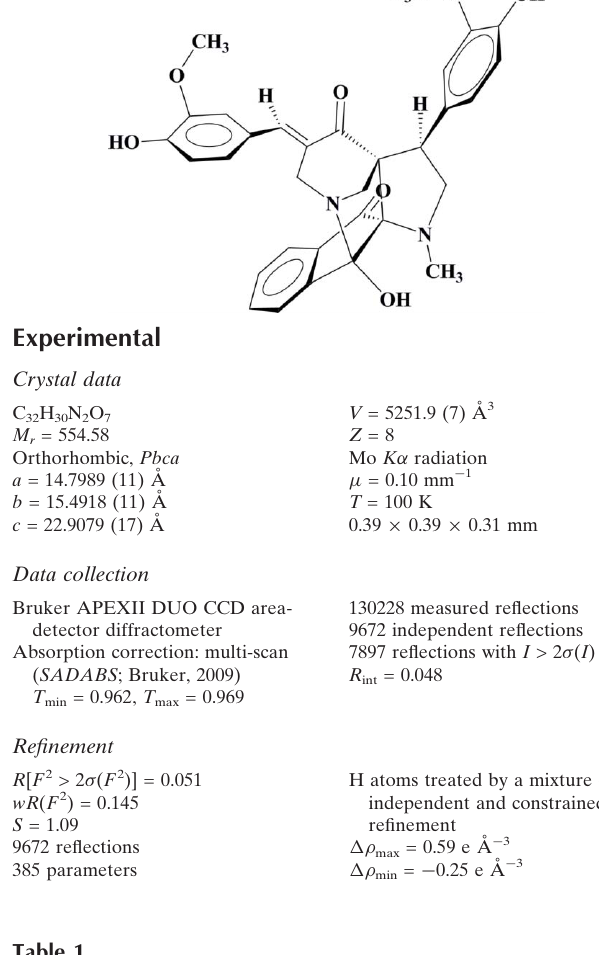
Hydrogen-bond geometry (A˚ , (cid:3)